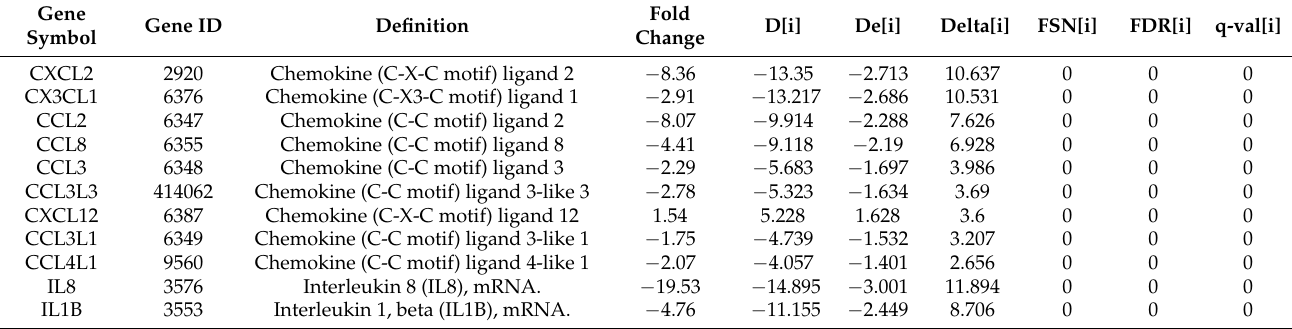
Table 2. Chemokines and